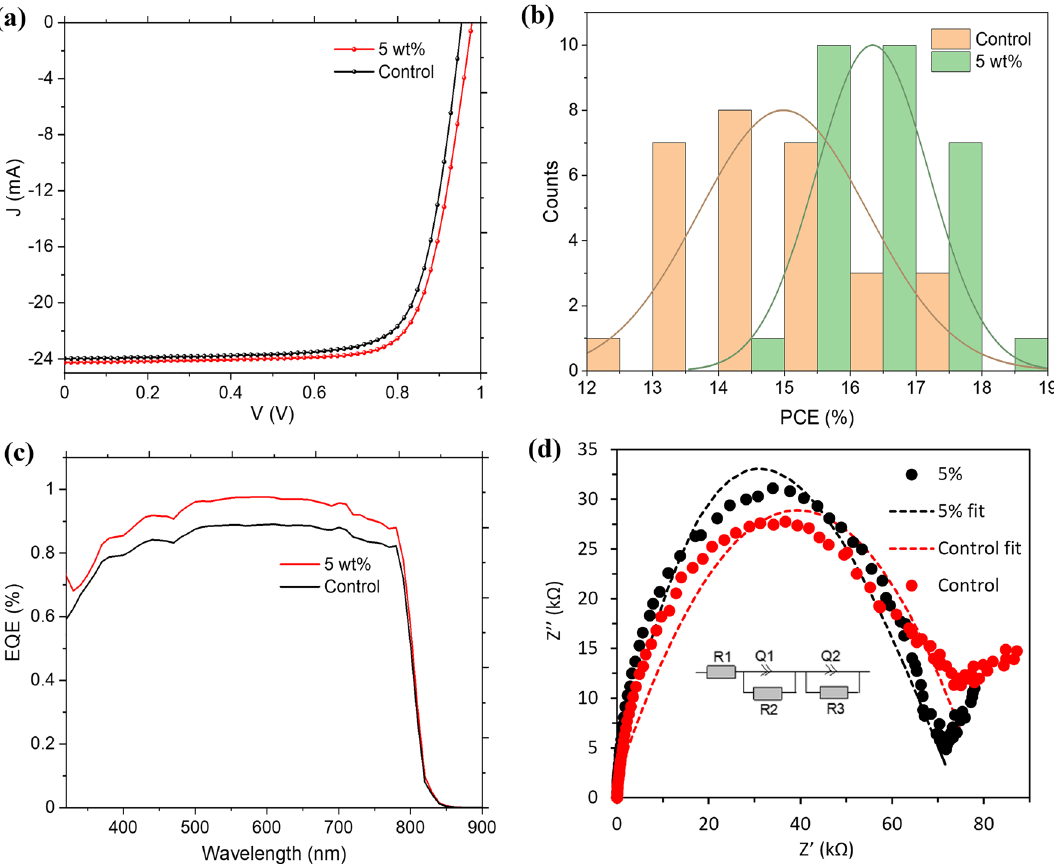
Figure 8. Comparison of ( a ) J–V curves, ( b ) statistical distribution of the PCE, ( c ) EQE, and ( d ) Nyquist plot for the control and PEO-modified PSC devices. The inset in ( d ) is the equivalent circuit of the